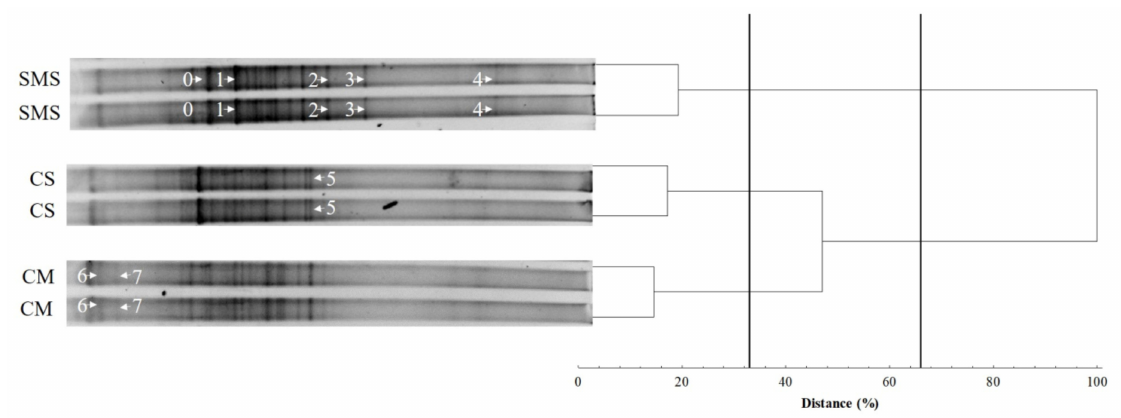
Figure 2. The DGGE profile of the fungal communities in soil treatments and the UPGMA dendrogram generated is based on the DGGE profiles. The numbers and arrows on the gel indicate specific bands related to the treatments. SMS—spent mushroom substrate, CM—chicken manure, CS—control